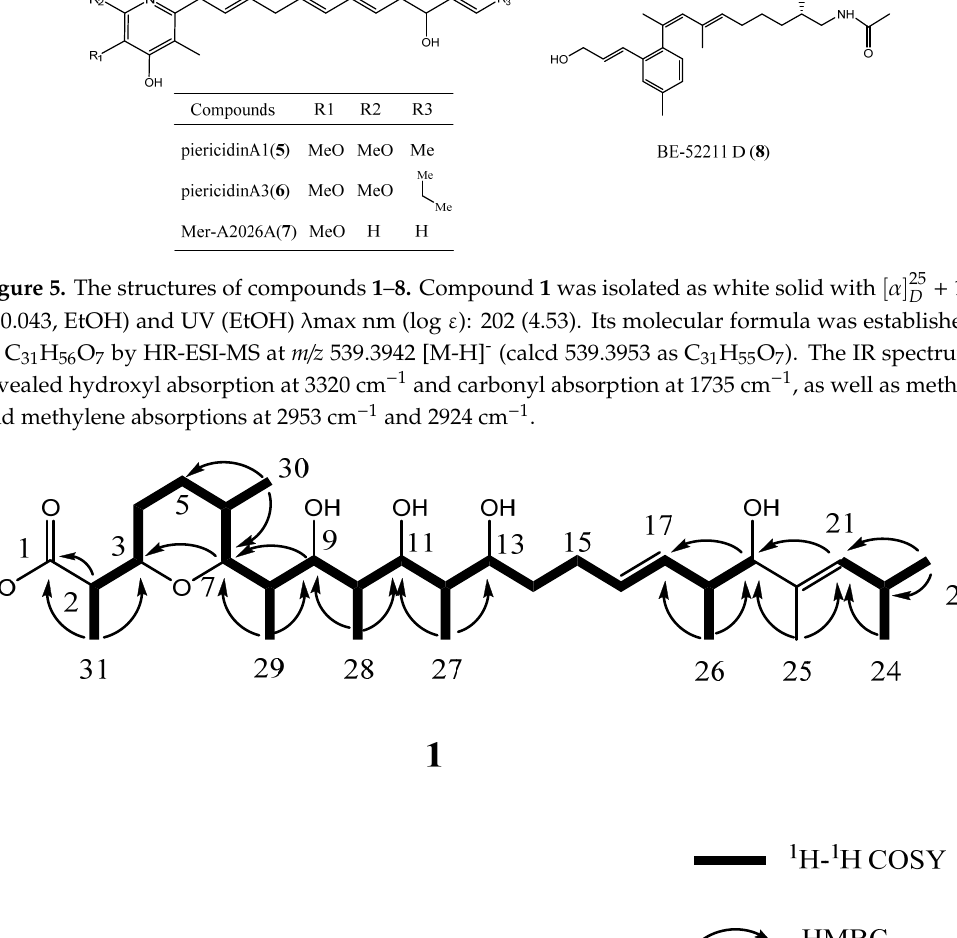
Figure 6. 2D nuclear magnetic resonance (NMR) correlations of compound 1.